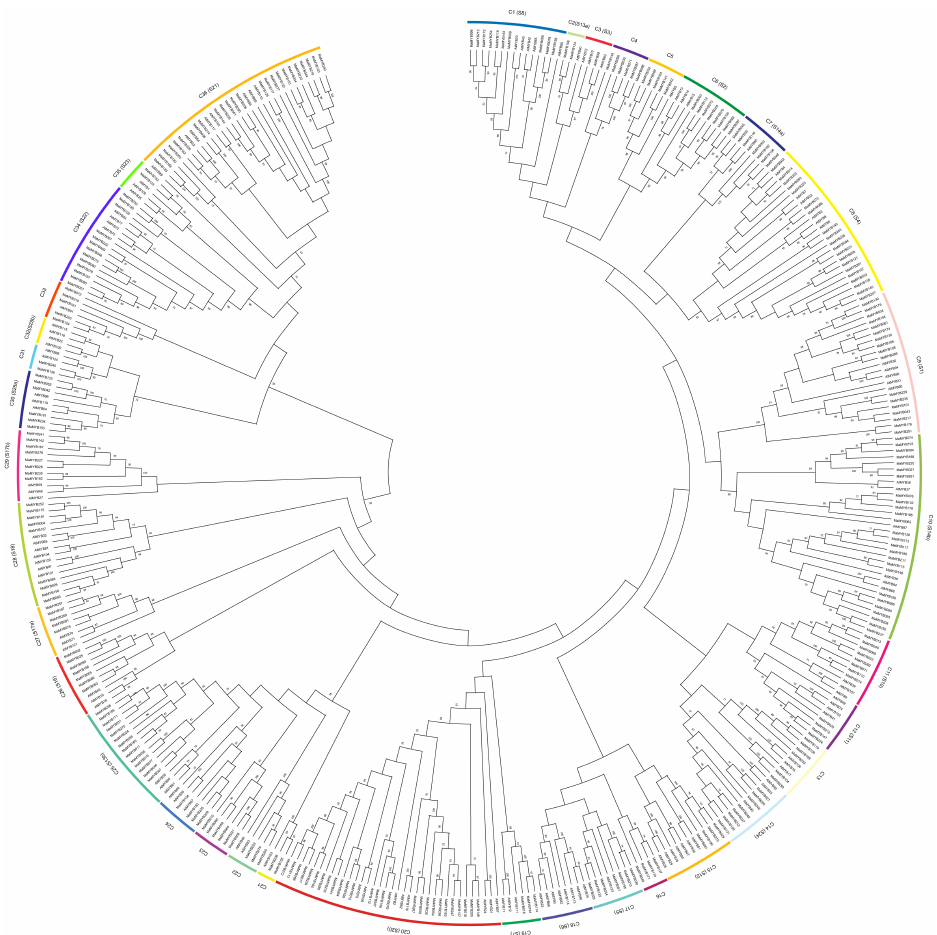
Figure 1. Illustration of the underwater network model. Figure 1. Phylogenetic analysis of R2R3-MYB from Arabidopsis and Musa acuminata genomes. The maximum likelihood (ML) tree was drawn using MEGA 6.0 with 1000 bootstrap replicates.